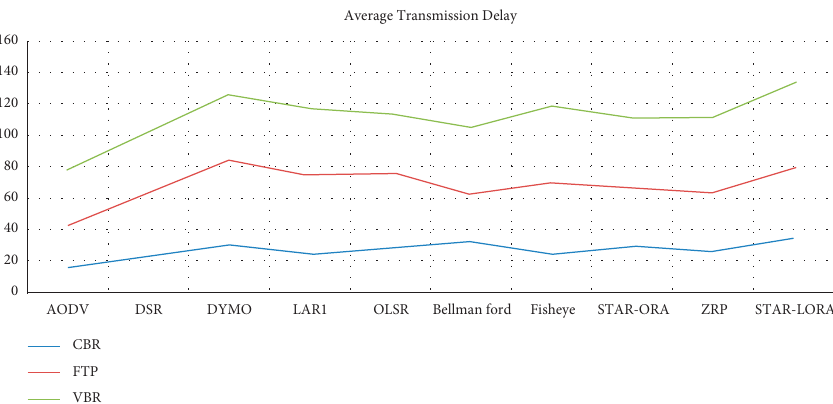
Figure 16: Average transmission delay of all routing protocols for 60 nodes.